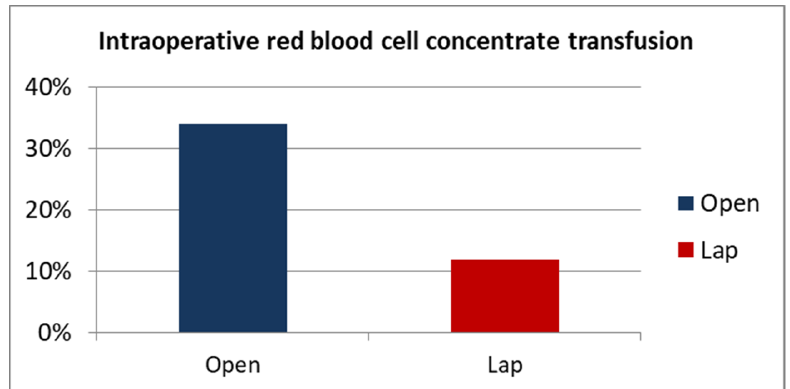
Figure 3. Intraoperative RBC concentrate transfusion ORC vs. LRC percentage.